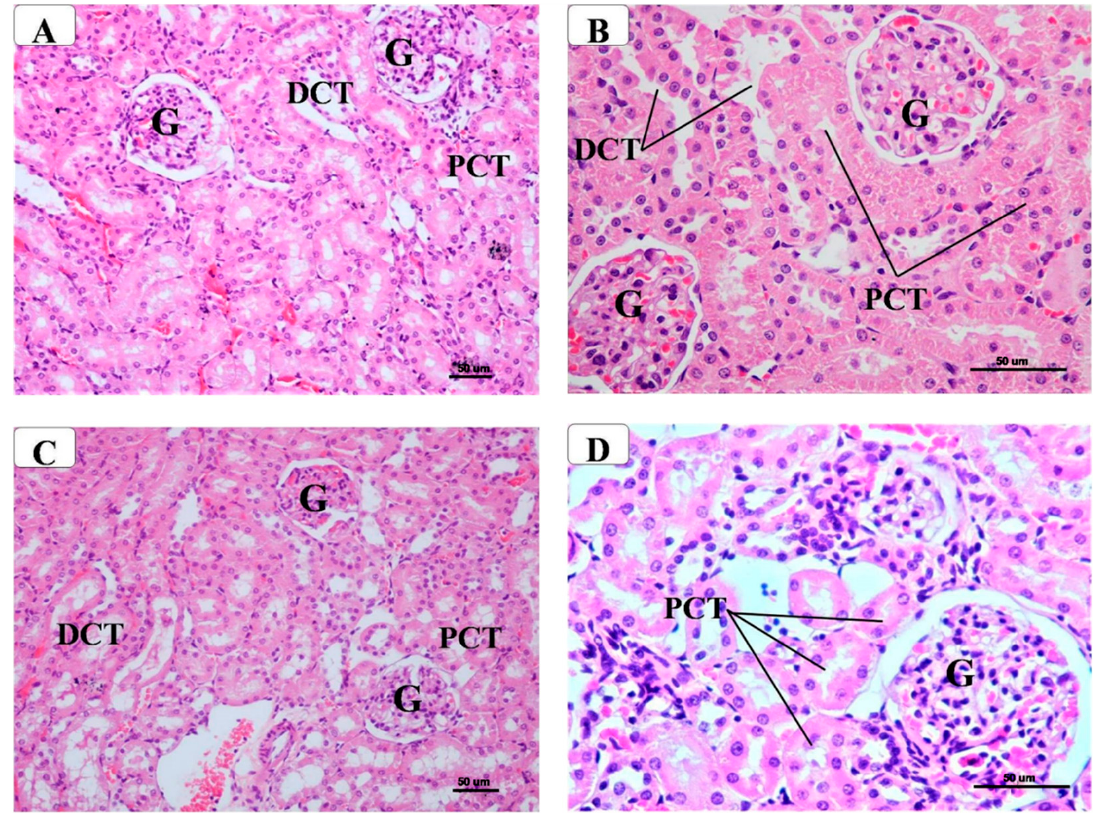
Figure 3. Representative photomicrographs of the histological structure of the renal cortex in the rat’s groups of metabolic syndrome treated with AM6545 ( A , B ) and AM4113 ( C , D ) CB1 receptor antagonists. Notice the restoration of nearly normal appearance as compared to the control group regarding the glomeruli (G) and tubules (PCT, DCT). (H&E— A , C × 200— B , D × 400).